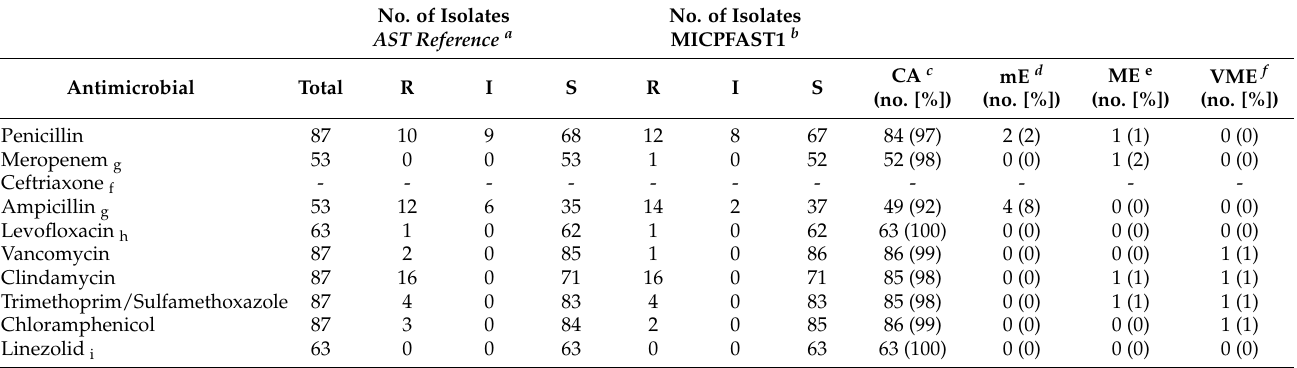
Table 6. Results for Streptococcus spp. test tested with the MICFAST1 standard turbidity inoculum method and visual reading versus AST reference